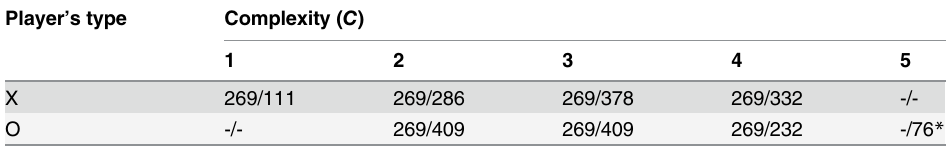
Table 3. The df games implemented and observations in the AI/HU